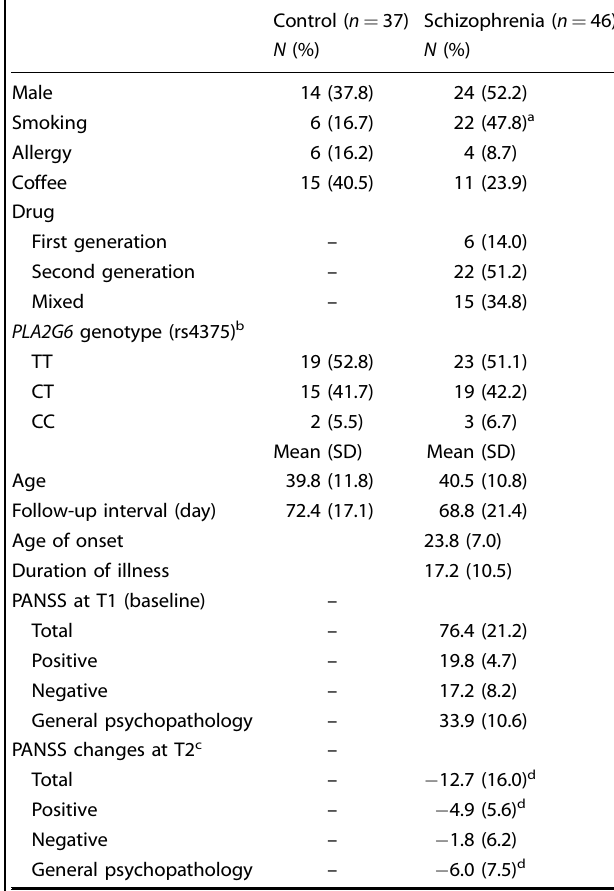
Table 1. Sociodemographic and clinical characteristics of the participants in this